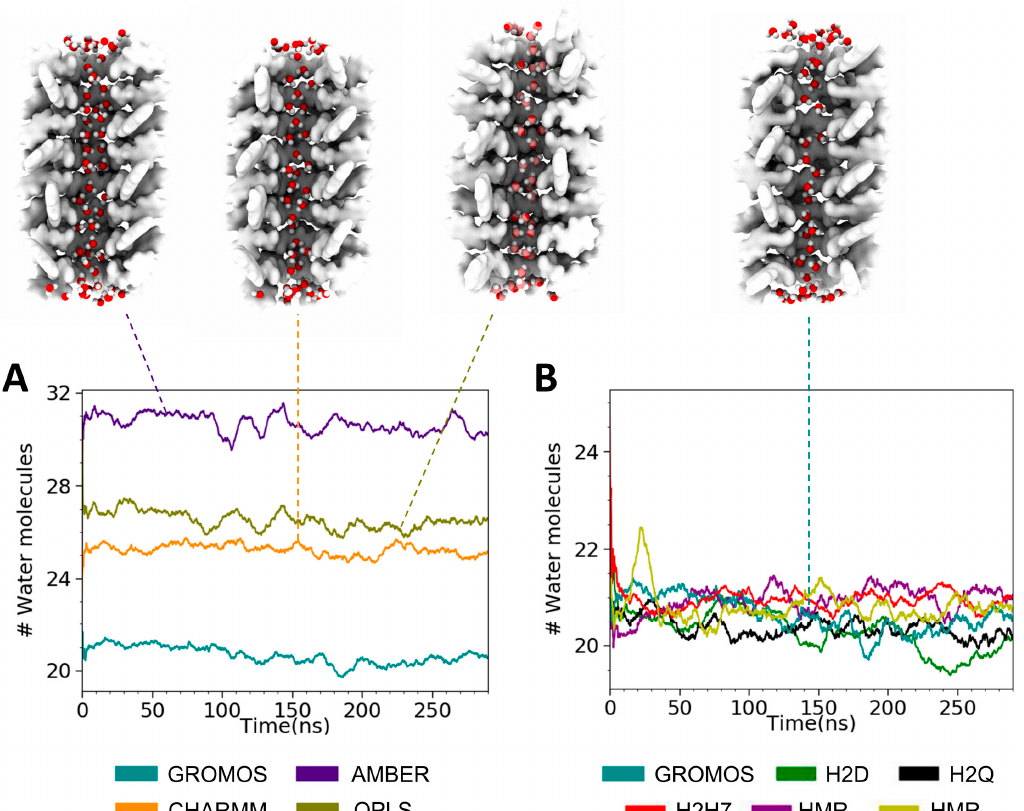
Figure 8. Evolution of the number of water molecules inside the SCPN along the trajectory, for each force field ( A ), and for the modified parameterizations of GROMOS based on hydrogen mass repartition/increase ( B ).